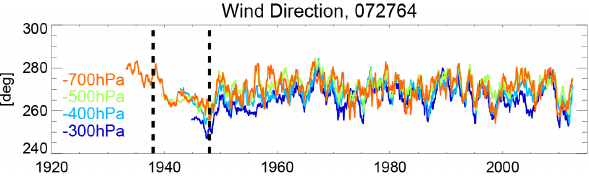
Figure 2. Time series of wind direction observations at station Bismarck (072764, North Dakota, USA), at the 700 (orange), 500 (green), 300 (light blue) and 200 (dark blue) hPa levels, respec- tively. A 365-day running mean has been applied to all time series. Note shifts in 1938 and